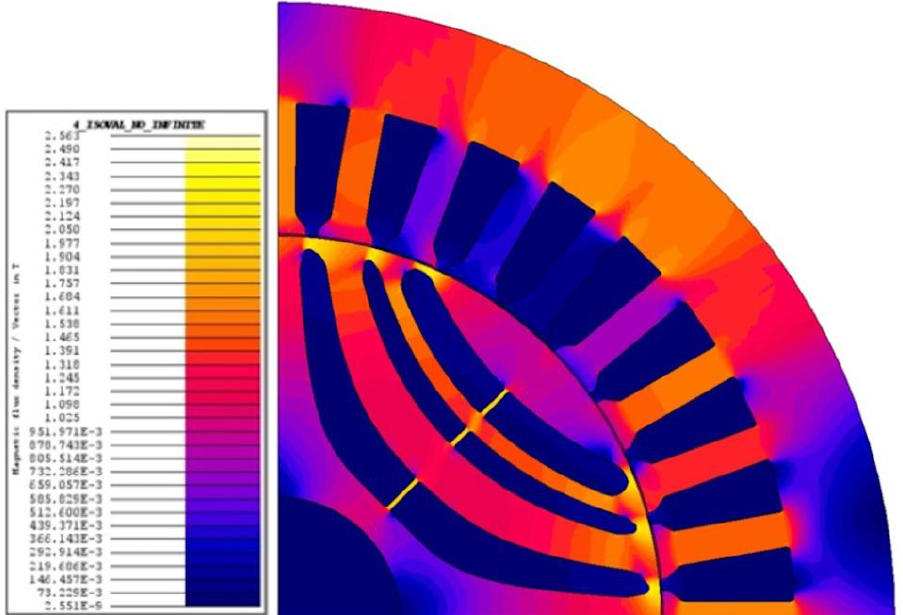
Figure 12. Flux density distribution color map of the best configuration chosen, in which the ends of the barriers have been rounded. The numerical values written on the right correspond to the colors which represent the magnetic flux density in the different zones of the machines and are expressed in Tesla (T).